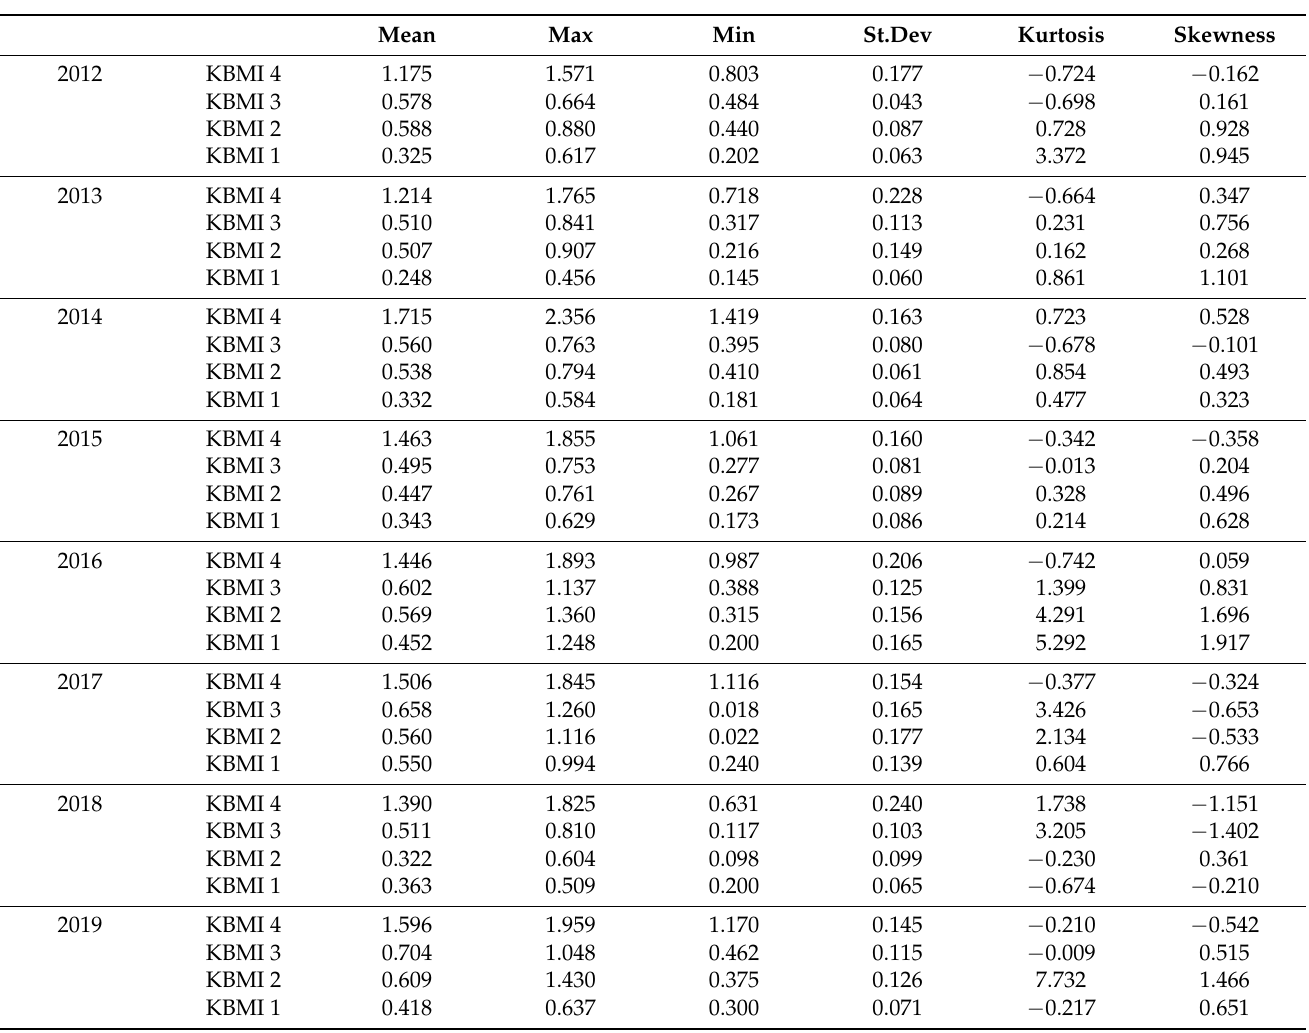
Table 8. Beta of sample groups